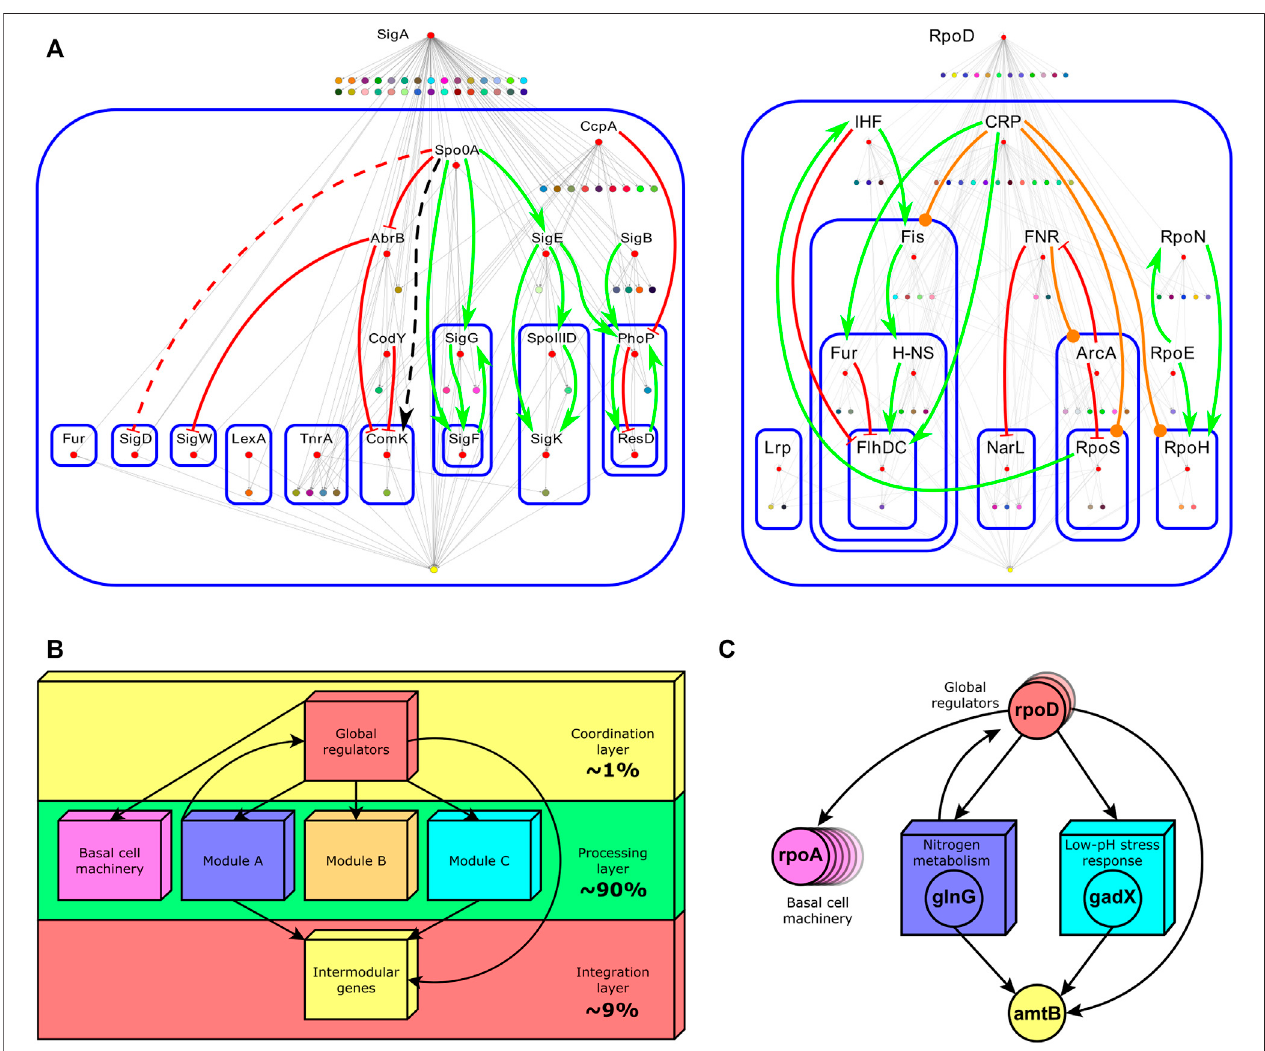
FIGURE 2 | (A) Hierarchies identi fi ed by the theoretical pleiotropy approach for B. subtilis (left) and E. coli (right). Labeled red nodes are global regulators. Nodes composing modules were shrunk into a single colored node. At the bottom of each fi gure, the yellow node contains the set of intermodular genes. Continuous arrows (red for negative interactions, green for positive ones, orange for duals, and black for interactions whose sign is unknown) indicate regulatory interactions between global regulators. Blue rounded-corner rectangles bound hierarchical layers. For a detailed description of this fi gure, the reader is referred to the original caption (Freyre-Gonzalez et al., 2012) 1 . (B) The common functional architecture found across bacteria by the NDA. Percentages indicate the fraction of genes in the GRN composing that layer. (C) A biological example of each layer composing the functional architecture of the E. coli GRN. The global regulator rpoD is one of the several global regulators controlling genes in many modules (concilions and regulons). Global regulators also control many single genes or operons not regulated by local regulators (basal machinery). Two examples of modules, ‘ Nitrogen metabolism ’ and ‘ Low-pH stress response ’ , are shown. They jointly control the intermodular gene amtB via the local regulators glnG (NtrC) and gadX (GadX). NtrC is the general regulator of the nitrogen assimilation pathway. GadX is one of the central regulators of the glutamate-dependent acid resistance system (GAD system). The amtB gene encodes an NH + 4 antiporter. Disruption of this gene impaired the growth on ammonium only under acidic conditions. Ammonium is also a precursor of glutamate, which plays a central role in the GAD system. This shows that intermodular genes integrate disparate physiological responses coming from different